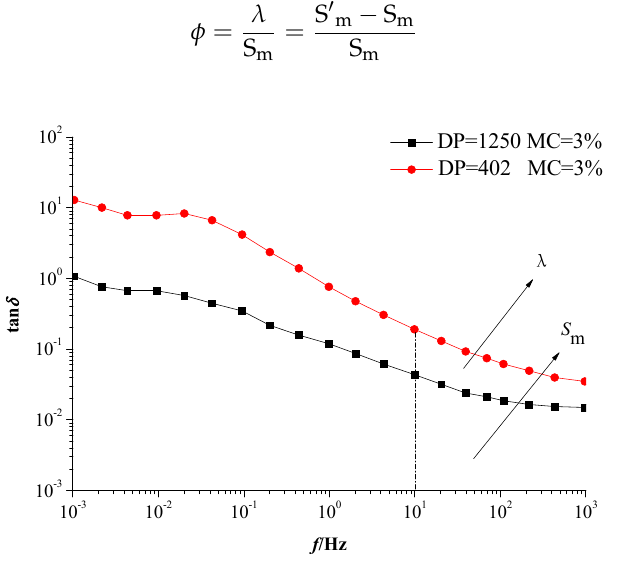
Figure 7. Description of aging compensation factor.